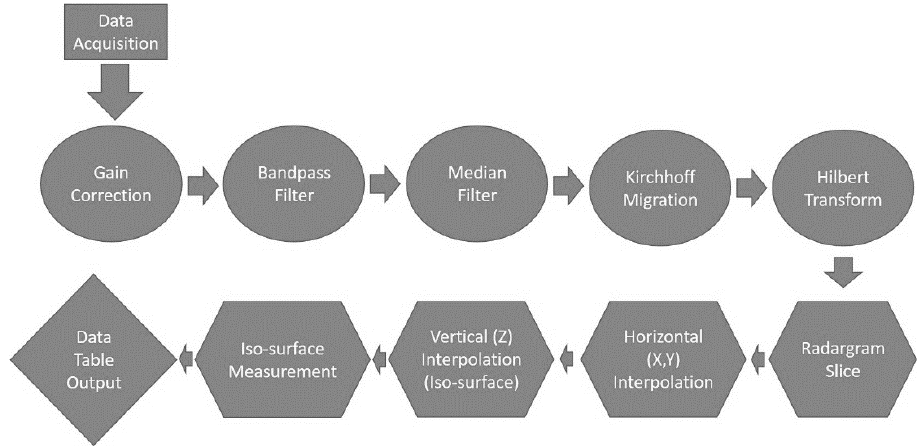
Figure 6. Flow diagram of pre-processing and processing steps for data extraction.